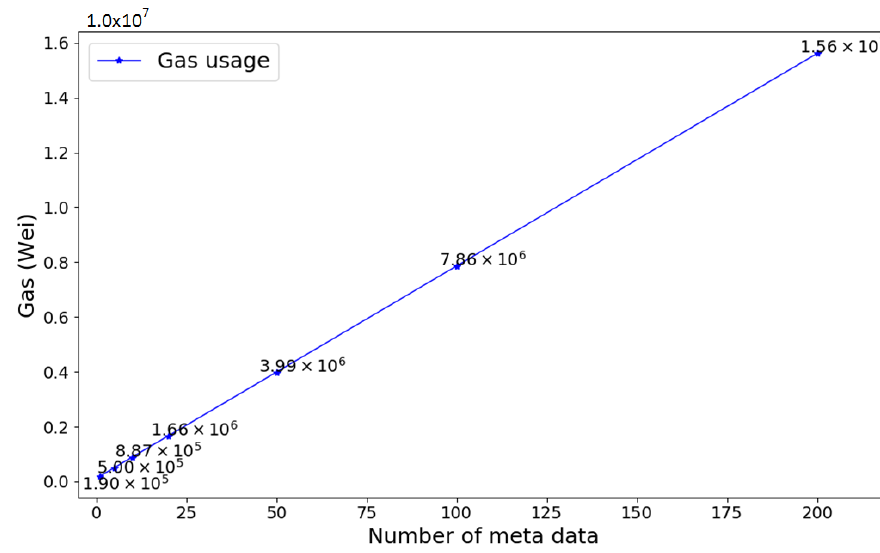
Figure 4. Gas usage in data